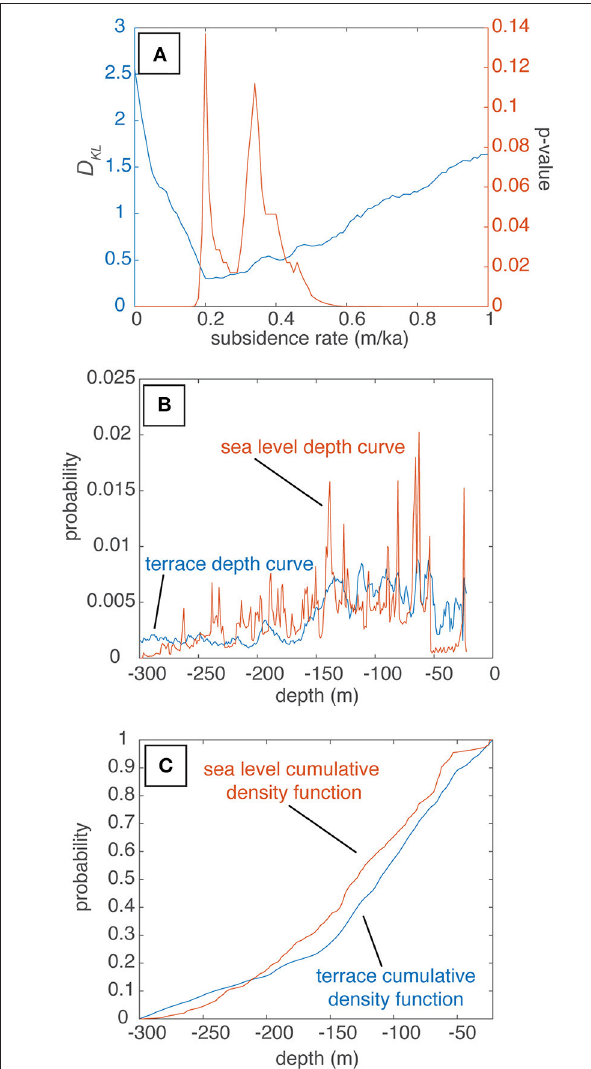
FIGURE 12 | Comparison of sea level data with terrace depths at various subsidence rates. (A) Kullback-Leibler Divergence ( D KL ; blue line) and k-s test (red line) results comparing terrace to sea level distributions adjusted by subsidence rates between 0 and 1 m/ka. The minimum D KL between the two distributions is 0.2 m/ka, and the cumulative distribution function of the curves are indistinguishable at the 2-sigma confidence interval between about 0.2 and 0.4 m/ka. (B) Comparison of probability density functions for terrace distribution (blue line) and time integrated sea level distribution adjusted for a subsidence rate of 0.2 m/ka (red line) used for calculating the D KL . (C) Comparison of cumulative density functions for terrace distribution (blue line) and time integrated sea level distribution adjusted for a subsidence rate of 0.2 m/ka (red line) used for performing the k-s test.